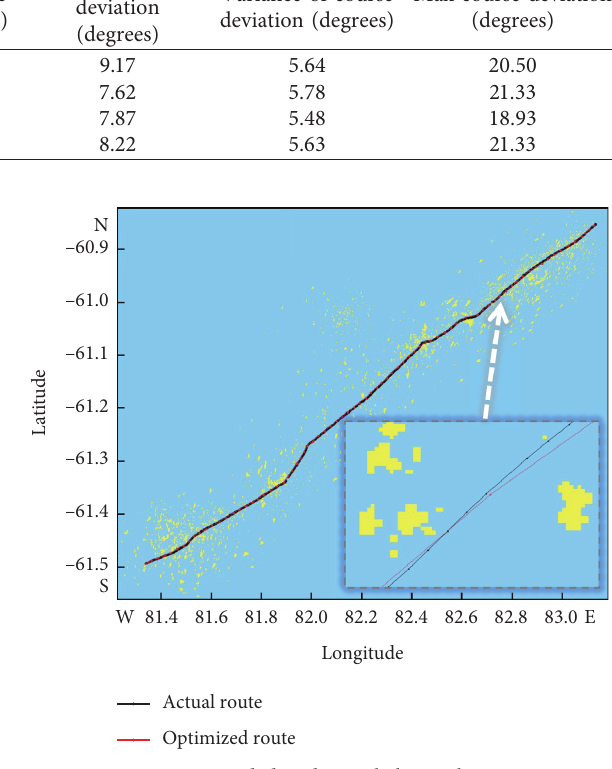
Figure 16: Recommended and actual ship sailing